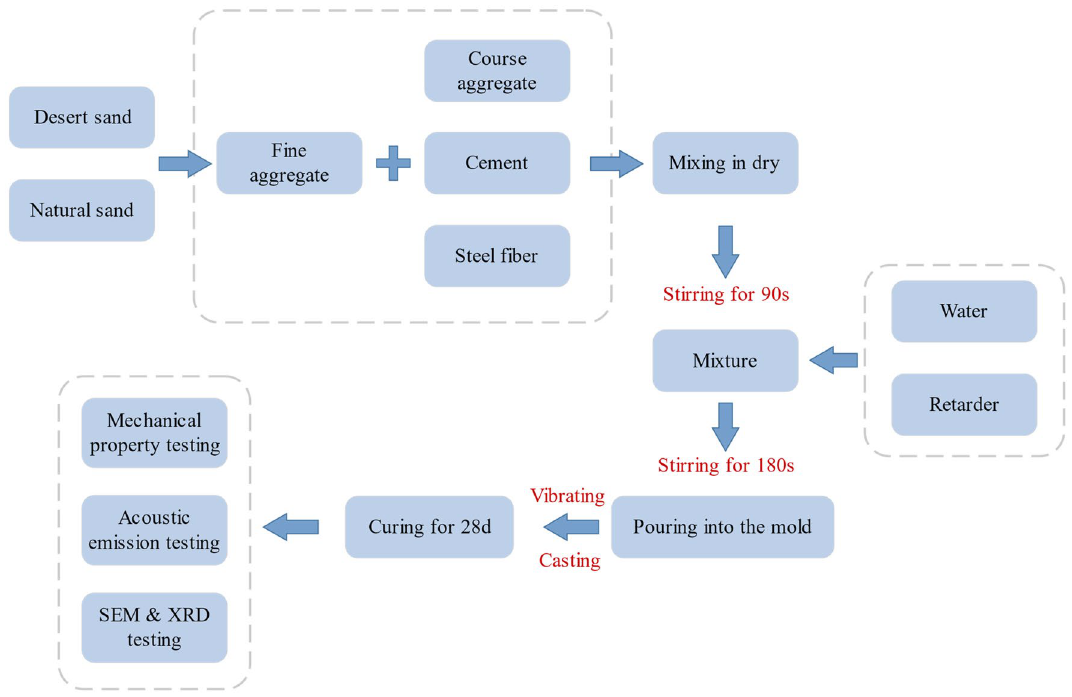
Figure 2. Test flowchart of steel fiber desert sand